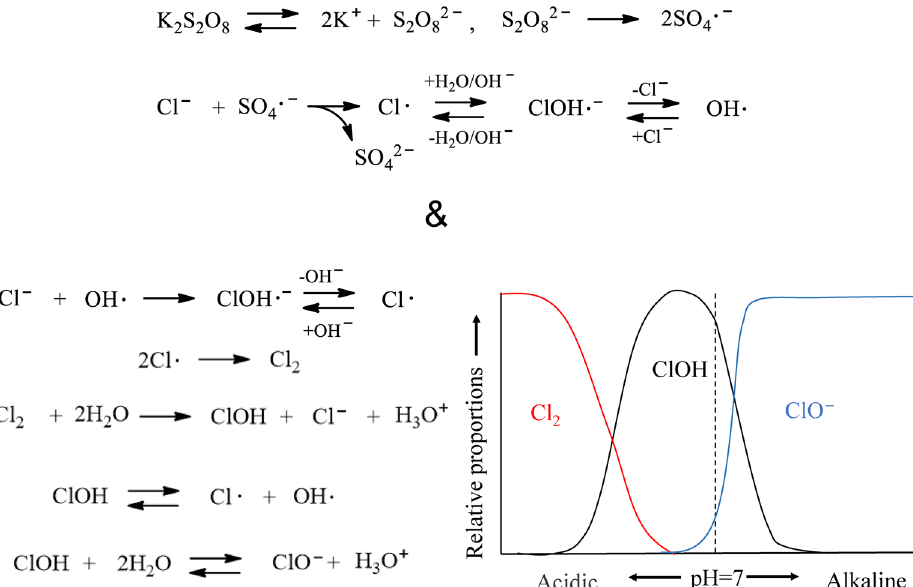
Figure 3. A transformation of radical species from SO 4 · − to OH· in seawater, mechanisms for transfer reaction to Cl − and generation of chemical composition of Cl 2 solution in function of